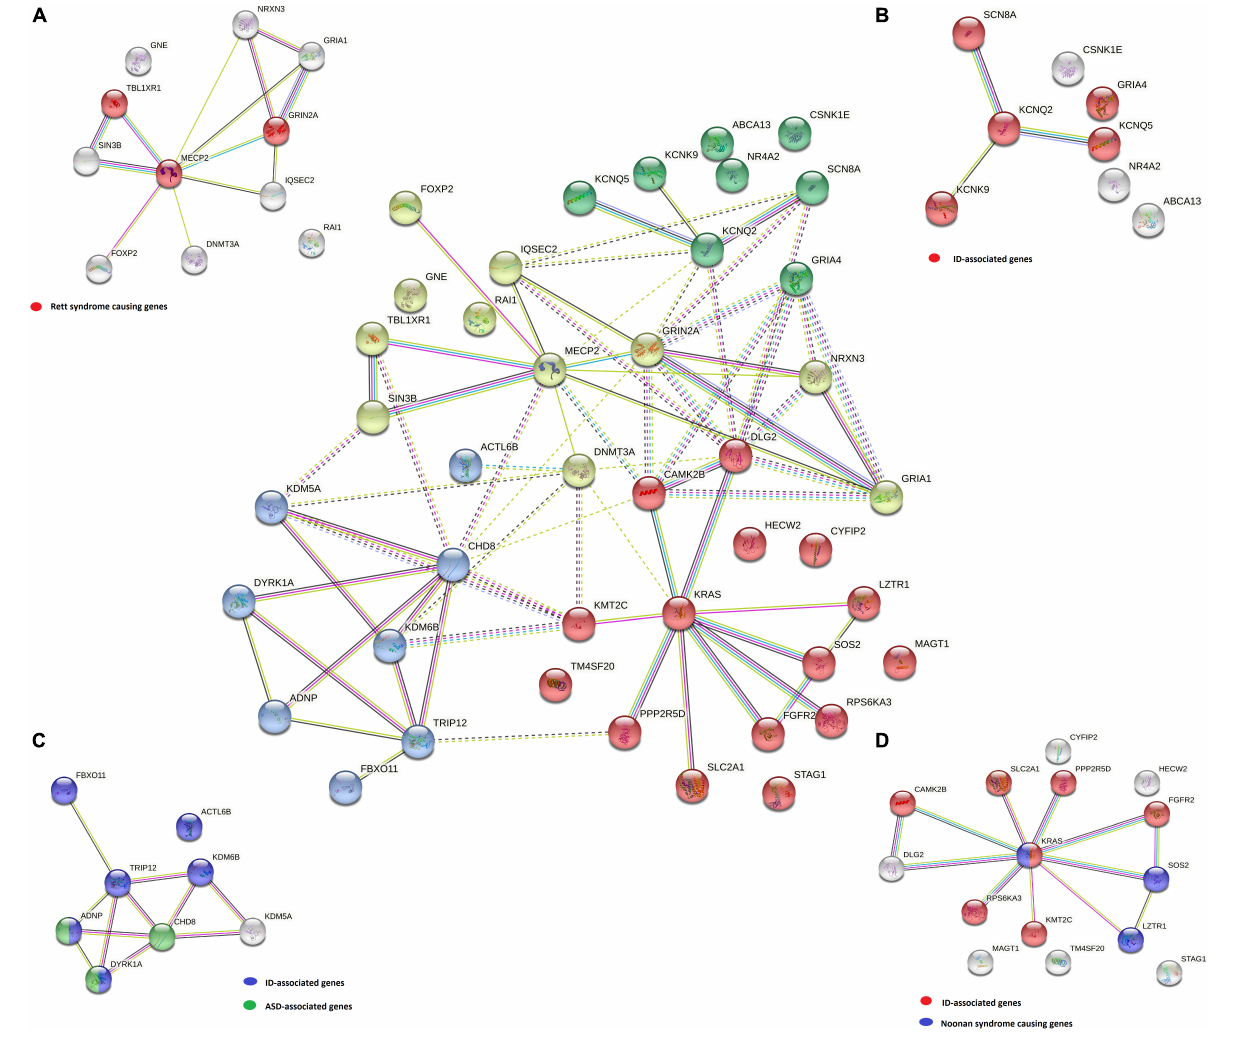
FIGURE 3 | A STRING k -means clustering classified the genes into four groups: yellow (A) , green (B) , blue (C) , and red (D) by possible correlation in the same biological pathways and/or involvement in specific phenotypes (diseases). For each group, specific disease-gene associations are marked on the isolated figure forms (A–D)